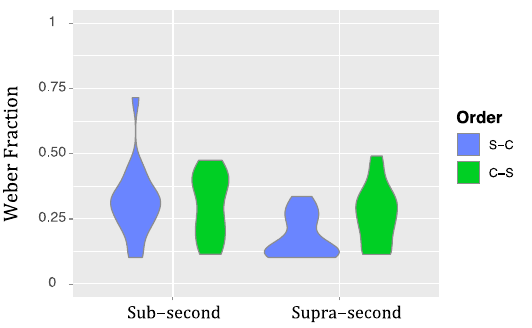
Figure 10. Weber Fractions. Violin plots of the Weber Fractions for each duration range and presentation order, across participants of Experiment 3 (logarithmically spaced ratios). The corresponding ANOVA showed a main effect of duration range ( p < 0.001, η 2 G = 0.12), a main effect of presentation order ( p < 0.05, η 2 G = 0.02) and a significant interaction ( p < 0.05, η 2 G = 0.04). Holm-Bonferroni corrected post hoc tests showed that the S-C order of the Supra-second condition differed from all others (vs. Sub-second S-C: p < 0.001; vs. Sub- second C-S: p < 0.01; vs. Supra-second C-S: p < 0.01) and that all remaining comparisons were not statistically